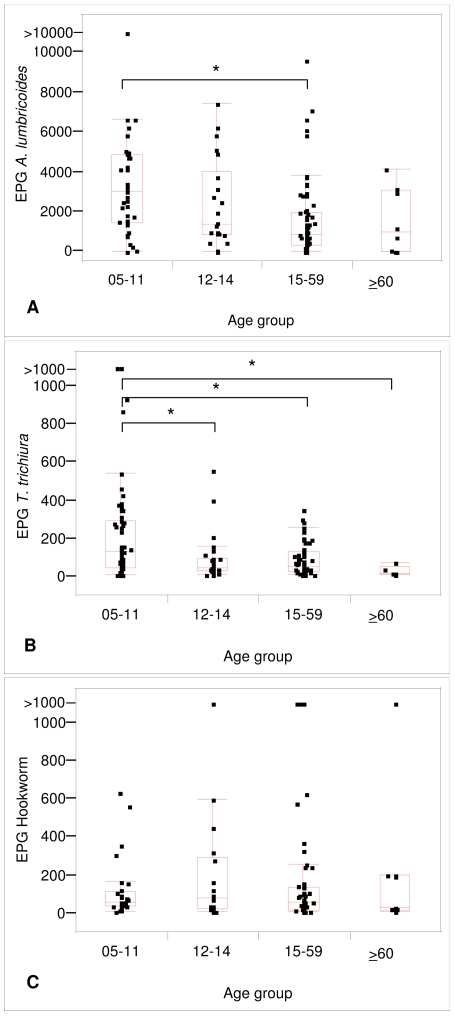
Age group specific differences in helminth infection intensities as expressed by egg excretion.Eggs per gram (EPG) values of infected individuals in different age groups of two Zanzibari communities: rural Bandamaji and peri-urban Dole. Each person's EPG was estimated as the arithmetic mean of at least two Kato-Katz thick smear readings. Differences in the median EPG of the four age groups were determined using the Kruskal-Wallis test. Pair-wise comparisons between the median EPG of two age groups were adjusted for multiple testing as suggested by Siegel and Castellan (1988) [35]. Horizontal bars are indicating the significant differences of the median EPG between two groups. Box plot: the ends of the box represent the 75th and 25th percentiles; the middle line represents the median; the upper whisker represents the upper quartile + 1.5*(interquartile range); the lower whisker represents the lower quartile–1.5*(interquartile range). (A): EPG values of A. lumbricoides infections, Kruskal-Wallis test: p<0.001; age group 5–11 years: n = 43; age group 12–14 years: n = 22; age group 15–59 years: n = 66; age-group ≥60 years: n = 8. (B) EPG values of T. trichiura infections, Kruskal-Wallis test: p<0.001; age group 5–11 years: n = 55; age group 12–14 years: n = 29; age group 15–59 years: n = 74; age-group ≥60 years: n = 5. (C) EPG values of hookworm infections; Kruskal-Wallis test: p = 0.789; age group 5–11 years: n = 28; age group 12–14 years: n = 18; age group 15–59 years: n = 53; age-group ≥60 years: n = 10.